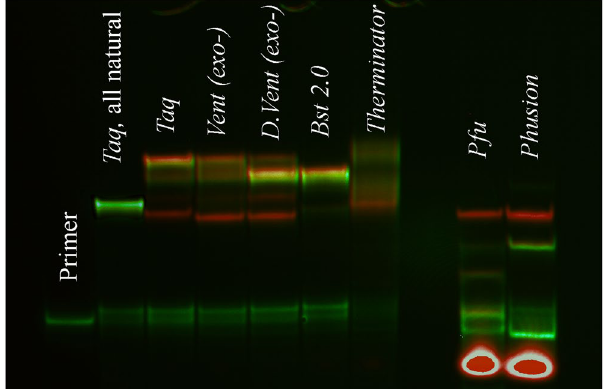
Figure 4. Gel-electrophoresis of the PE reactions in the presence of different exonuclease-deficient and proofreading DNA polymerases at 72 °C. The reaction was performed for 2 h at dNTP concentrations of 200 μ M. The ability to modify the sequence ends decreases in the following order for non-proofreading polymerases: Taq > Vent (exo-) > DeepVent (exo-) > Bst 2.0 . The Therminator polymerase yields poor primer extension.